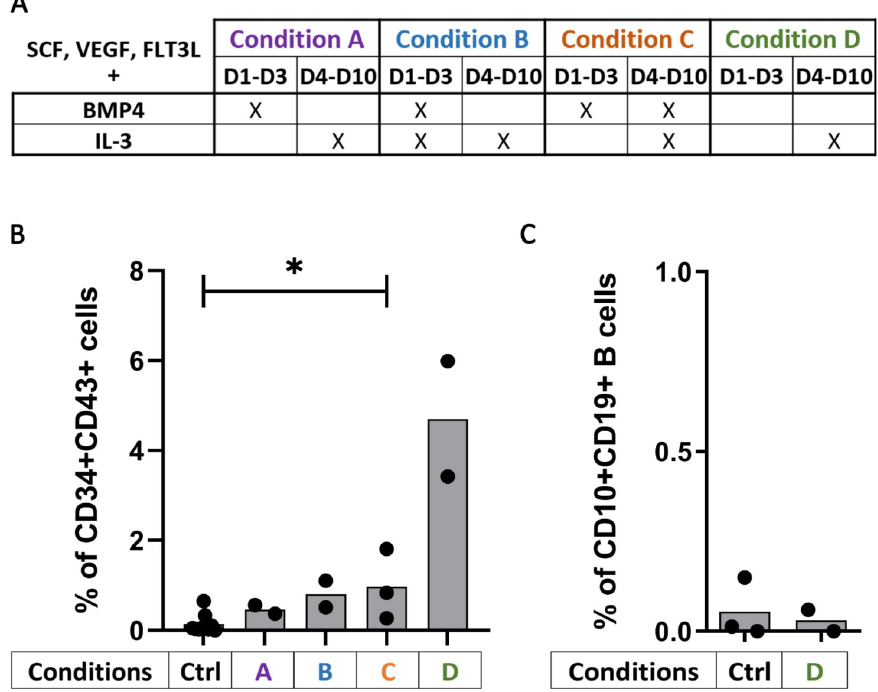
Fig 2. Cytokines allow CD34 + CD43 + differentiation from stem cells. (A) Table of the cytokine conditions tested according their presence from Day 1 to Day 3 and Day 4 to Day 10 for the CD34 + differentiation (cytokines were used at 10ng/ml except for BMP4 at 5ng/ml). (B) Percentage of CD34 + CD43 + cells at the end of the CD34 + differentiation according to the cytokine conditions used (n = 2 or 3 independent experiments) or without cytokines as control (Ctrl, n = 9 independent experiments). The significance of differences between the condition C and the Ctrl was determined using a Mann-Whitney Test; � p < 0.05. (C) Percentage of CD10 + CD19 + B cells at Day 21 of B cell differentiation from hESC-derived CD34 + with (Condition D; n = 2 independent experiments) or without cytokine (Ctrl, n = 3 independent